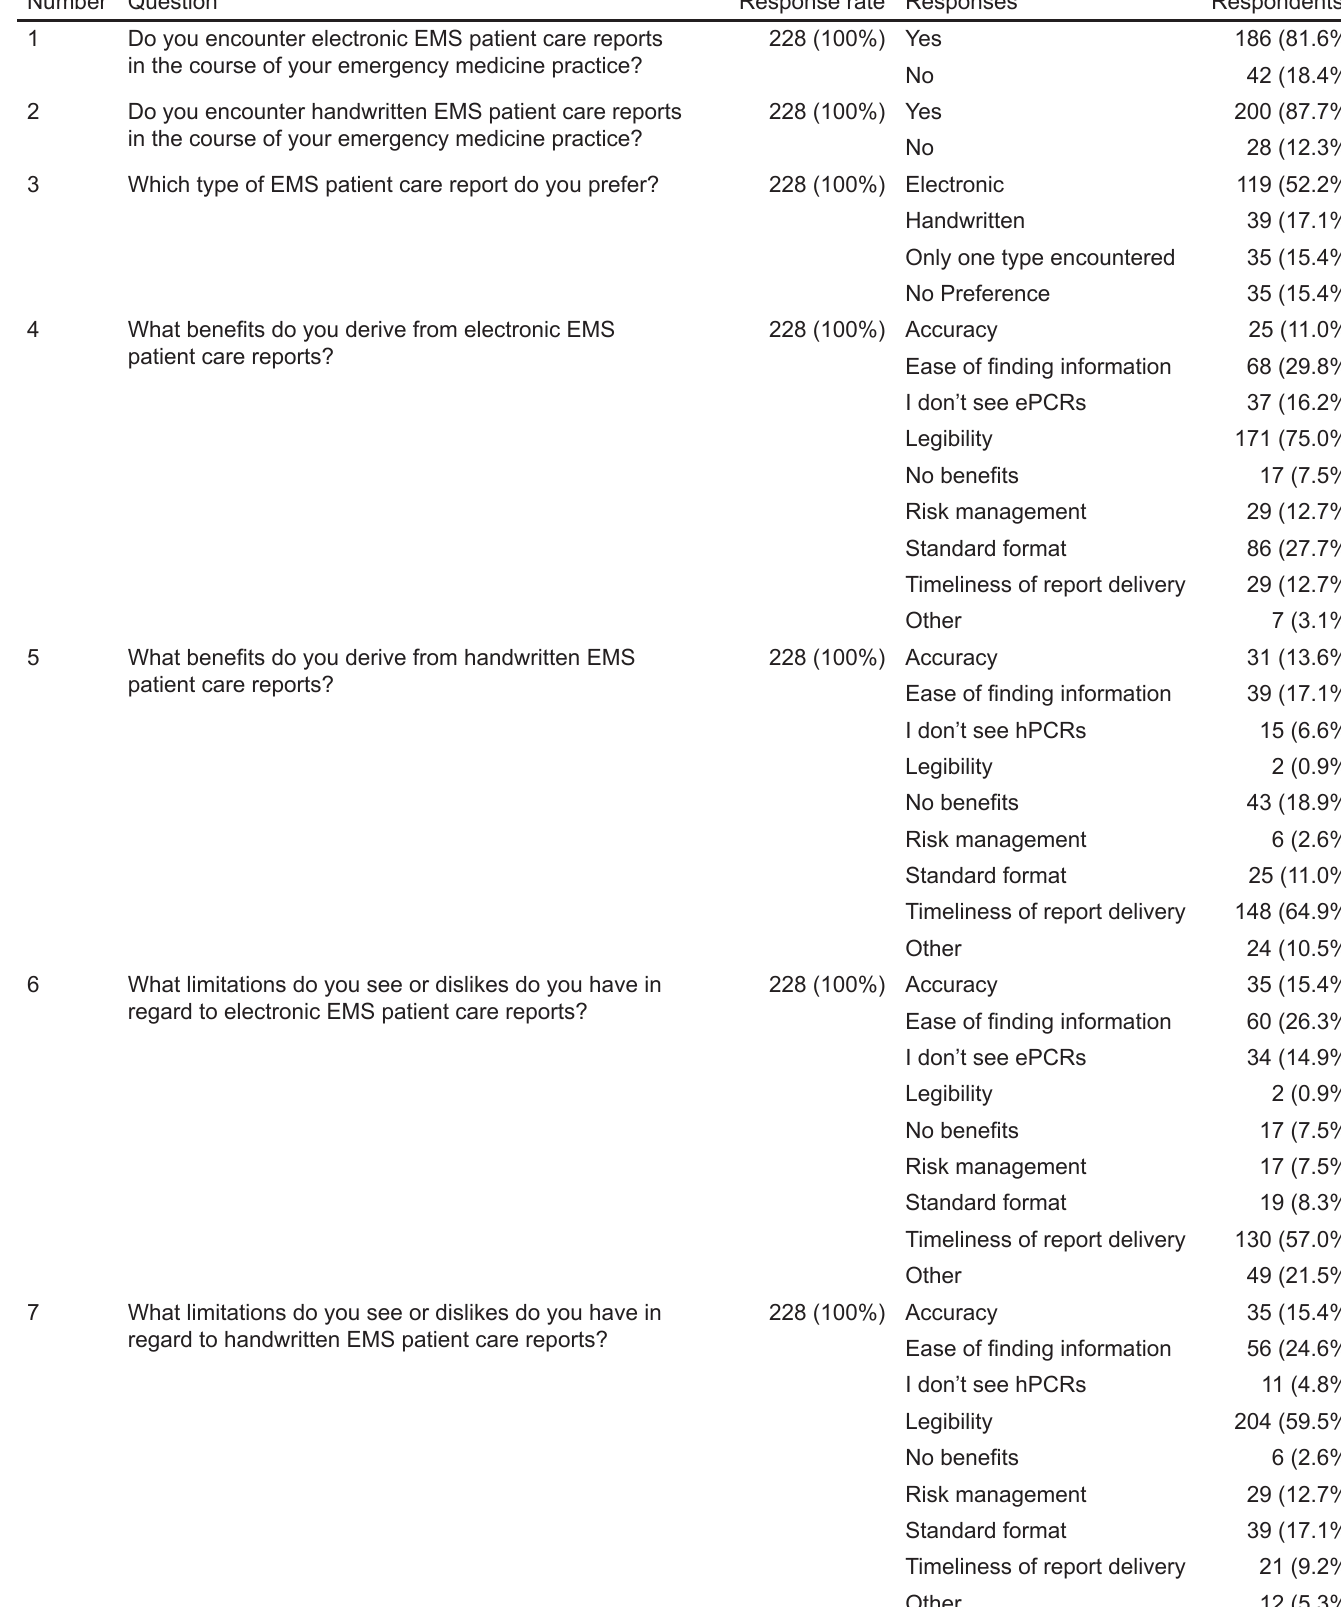
Table 2 . Survey responses regarding prehospital patient care